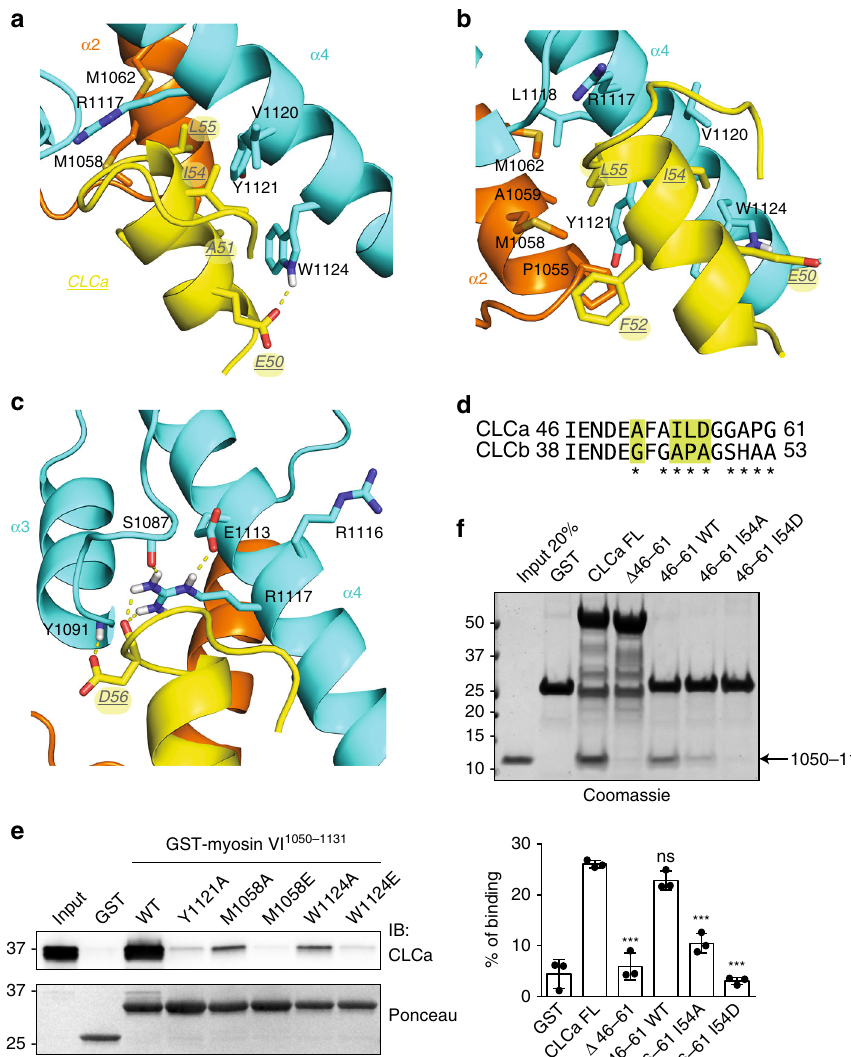
Fig. 4 A hydrophobic pocket formed by myosin VI encompasses residues I54 and L55 of CLCa. a Ribbon representation of the myosin VI:CLCa binding interface in the orientation of Fig. 3e with key sidechain heavy atoms displayed. Myosin VI α 4 residues R1117, V1120, Y1121, and W1124 (blue) interact with CLCa E50, A51, I54, and L55 (yellow). CLCa L55 also interacts with myosin VI α 2 residues, with M1058 and M1062 (orange) observable in this view. At the edge of the hydrophobic pocket lies a hydrogen bond between CLCa E50 and the myosin VI indole group. Sulfur and nitrogen atoms are in yellow and indigo, respectively. b As in a but rotated about the CLCa helix to highlight interactions involving the myosin VI isoform-speci fi c α 2 helix, especially P1055 and A1059. c Enlarged representation of the region containing myosin VI R1117 to highlight intramolecular and intermolecular hydrogen bonds. The guanidine group of R1117 forms hydrogen bonds to the backbone and sidechain carboxyl groups of myosin VI S1087 and E1113, respectively, and to the backbone carboxyl group of CLCa D56. This view is similar to that of a but rotated about the sidechain of R1117. In a , c , a dashed yellow line is used to indicate a hydrogen bond with oxygen and nitrogen atoms in red and indigo, respectively. d Sequence alignment of CLCa 46 – 61 with the corresponding region of CLCb. Asterisks indicate residues not conserved between isoforms. In yellow are amino acids putatively responsible for the selective binding. e Pull-down assay using the indicated GST-myosin VI 1050 – 1131 mutant constructs and lysates (1 mg) from HEK293T cells. After washes, bound proteins were eluted in Laemmli-buffer, resolved through SDS-PAGE, and IB was performed with the anti-CLCa antibody (×16). Ponceau detects equal loading of GST proteins. Representative image of three independent experiments is shown. f GST pull-down assay using the indicated CLCa constructs and puri fi ed fragment spanning amino acids 1050 – 1131 of myosin VI long . After washes, bound proteins were eluted in Laemmli-buffer, resolved through SDS-PAGE, and stained with Coomassie. Bottom panel, quantitation of three independent experiments. Data are expressed as percentage of binding with respect to input and normalized for the amount of GST proteins used in each pull-down. Error bars represent s.d. *** P < 0.001 by two-tailed T (Supplementary Fig. 9a) while single substitution of myosin VI signi fi cantly impairs binding to myosin VI, with aspartic acid M1058, Y1121, or W1124 led to reduced binding (Fig. 4e). FP showing the strongest defect (Fig. 4f). analysis revealed a 2 log-fold difference in binding af fi nity for the Y1121A mutant (Supplementary Fig. 9b). On the CLCa side, we tested the effect of substituting I54 with alanine or aspartic acid, Myosin VI requirement for CME in polarized cysts . While using CLCa full-length protein as a control. As expected, myosin CLCa is ubiquitously expressed in animal tissues 5 , the presence of VI 1050 – 1131 bound to CLCa WT but not Δ 46-61. 154A or I54D myosin VI long is restricted to organs containing polarized cells of